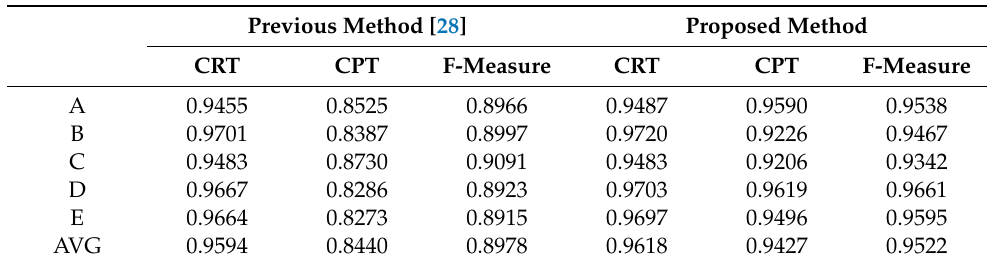
Table 4. Manhole cover assessment result comparison between the previous method [20] and proposed